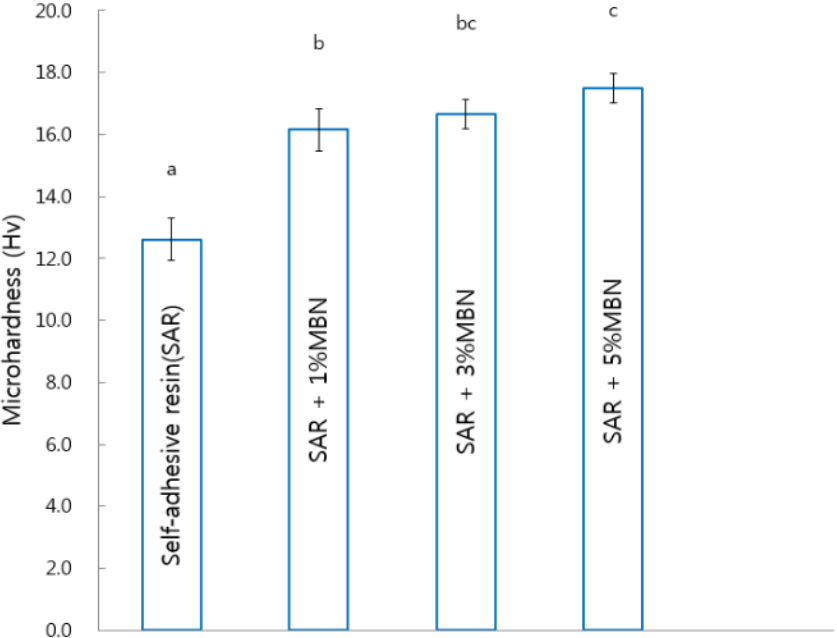
Figure 6. Microhardness comparison between control (SAR) and MBN-incorporated SAR. Labels with the same letters indicate no statistically significant difference between the groups. One-way ANOVA was performed ( n = 20).